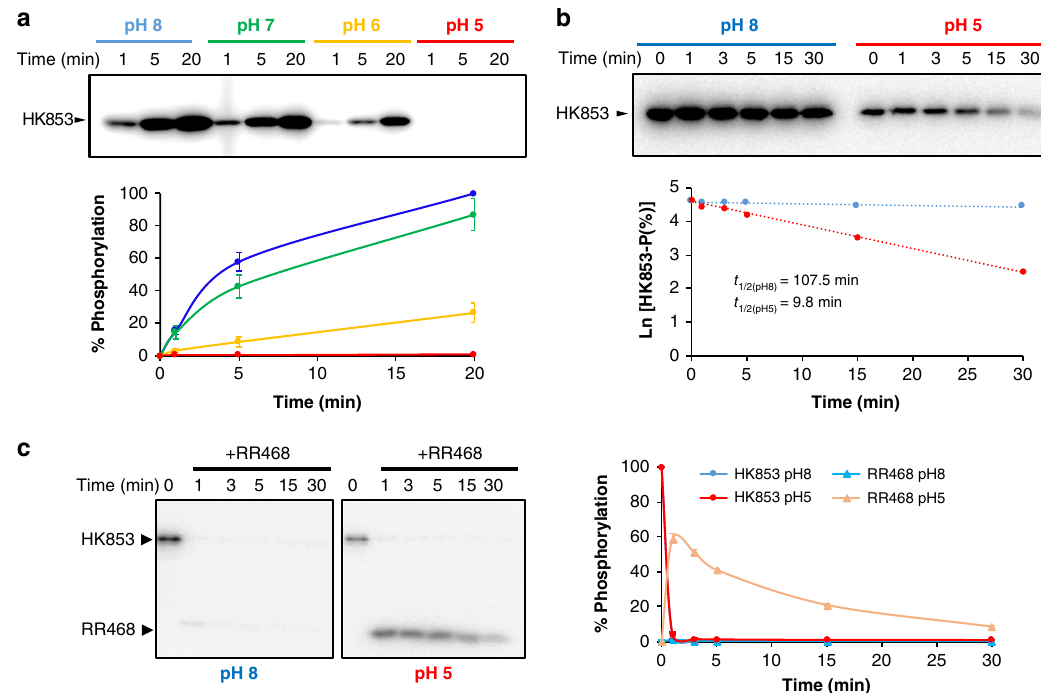
Fig. 5 Autophosphorylation of HK853 and phosphotransfer to RR468. a Time course of HK853 autophosphorylation with [ γ - 32 P] ATP at different pHs. b Stability of phosphorylated HK853 at acidic (5) and basic (8) pH. Phosphorylation was quanti fi ed by autoradiography, phosphorylation signals at t = 0 were set to 100% for each pH and phoshorylation were calculated accordingly. Values were plotted in a semi logarithmic scale over time, using a linear fi t to calculate half-life times of HK853 – P at each pH. c Time course of phosphotransfer from HK853 to RR468 at acidic (5) and basic (8) pH. Gels correspond to a representative experiment and quanti fi cation of three independent experiments are plotted. Error bars represent SD. Source data are provided as a Source Data fi